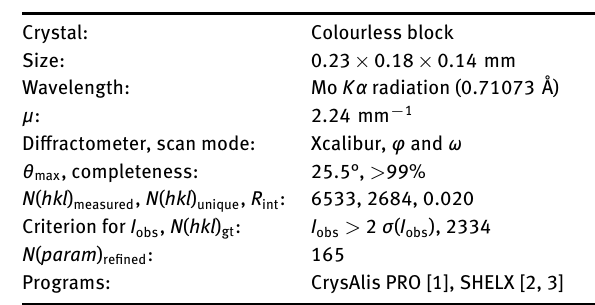
Table 1: Data collection and